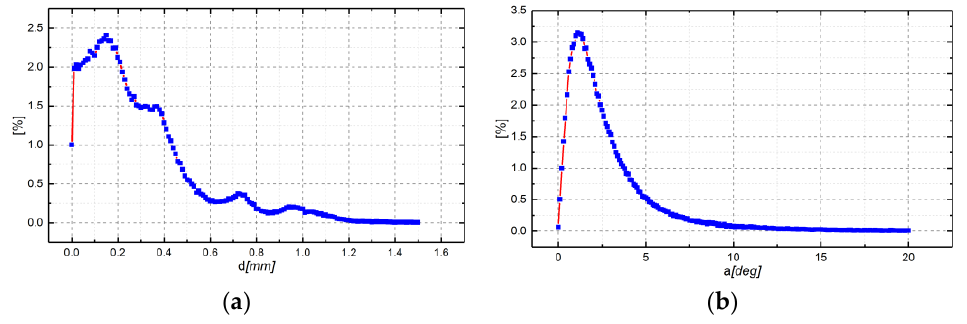
Figure 11. ( a ) Distribution of the translation error; ( b ) distribution of the angle error. Table 2. Statistic of the distance and angle error.